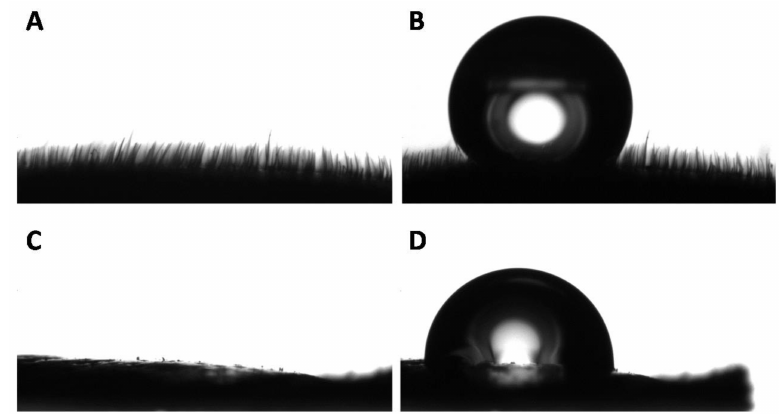
Figure 4. Representative side view of the white and black surfaces. ( A ) Profile of the white part of a G. orientalis elytron and ( B ) water droplet deposited on its surface. ( C ) Profile of the black part of a G. orientalis elytron and ( D ) water droplet deposited on its